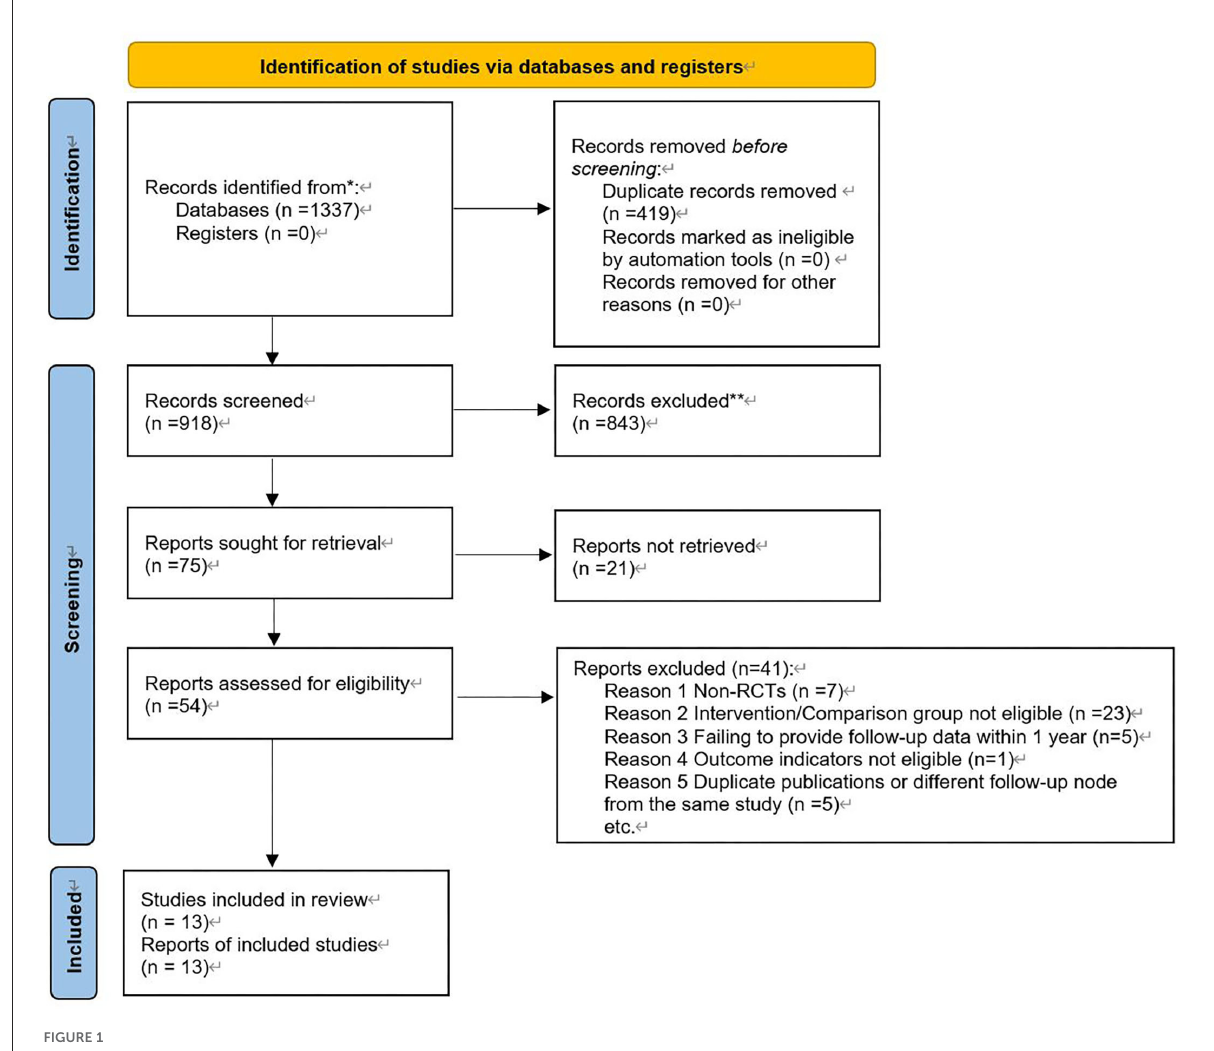
FIGURE1 Selection